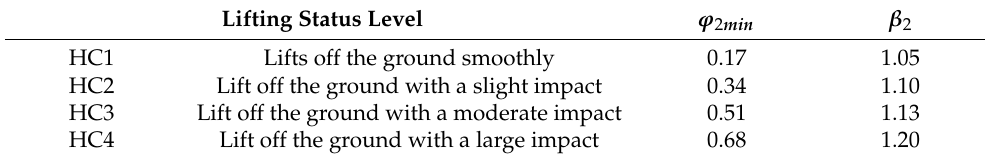
Table 1. Values of ϕ 2 min and β 2 .